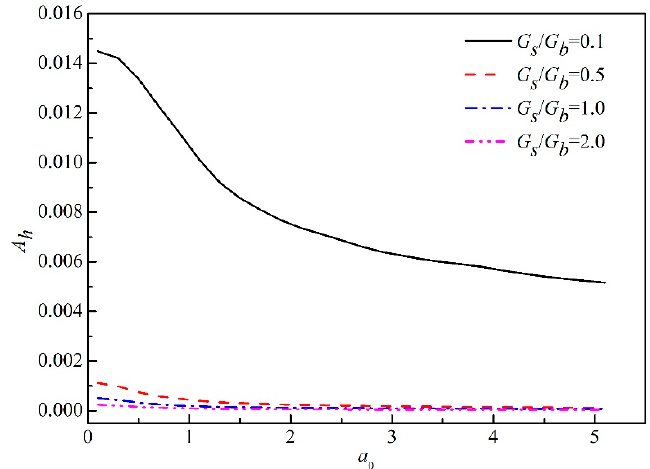
Figure 11. Dynamic response factor of embedded foundation under different soil stiffness.